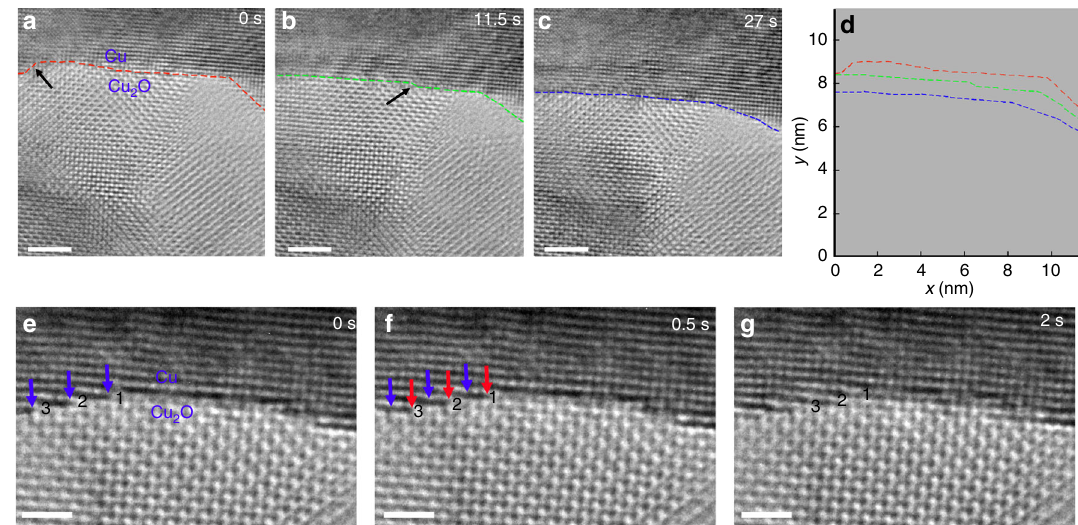
Fig. 2 Cu 2 O → Cu interfacial transformation. a – c HRTEM snapshots (Supplementary Movie 1) showing the Cu 2 O → Cu conversion at the Cu 2 O/Cu interface at T = 350 °C and p H 2 = 4 × 10 − 2 Torr, the colored dash lines outline the Cu 2 O/Cu interface, the black arrows mark the interface steps. d Traces of the position of the Cu 2 O/Cu interface at the different times show that the interface moves toward the Cu 2 O layer. e – g High magni fi cation view of the dynamics of the Cu 2 O → Cu interfacial conversion at T = 350 °C and p H 2 = 4 × 10 − 2 Torr (Supplementary Movie 2), the blue and red arrows point to the Cu 2 O/Cu interface step edge at 0 s and 0.5 s, respectively. Numbers 1, 2 and 3 mark the horizontal atomic planes at the Cu 2 O/Cu interface. Scale bar , 2 nm ( a – c ),